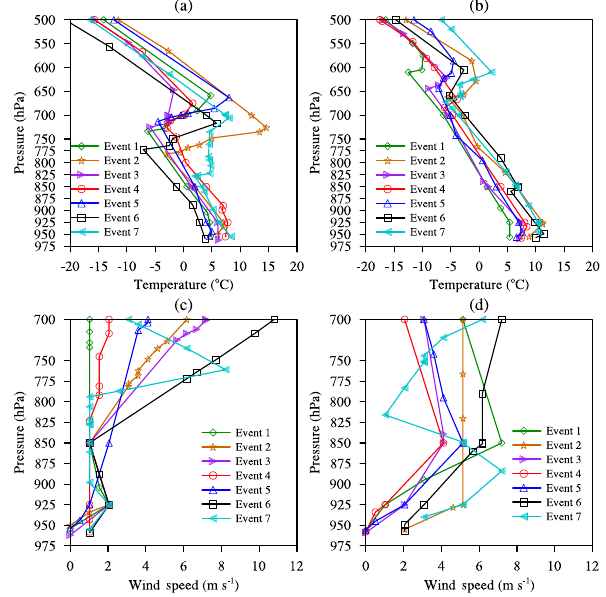
Figure 7. Vertical profiles of (a) temperature and (c) horizontal wind speed in the urban agglomeration during periods controlled by the low-pressure system. Vertical profiles of (b) temperature and (d) horizontal wind speed after the low-pressure system had tran- sited across the urban agglomeration for seven heavy air pollution events (events